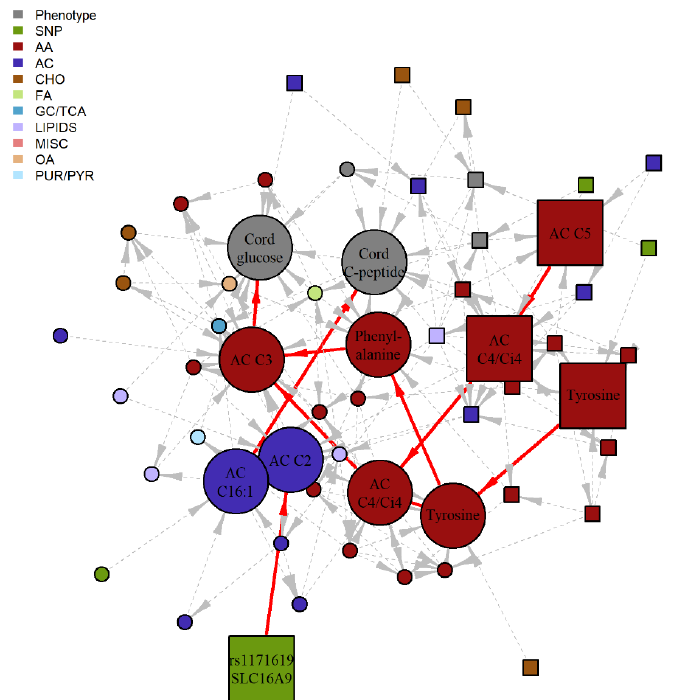
between them. The maternal features are represented by square nodes and the offspring features are represented by circle nodes. Newborn outcome variables are grey, genotypes are green, and the remaining colors correspond to different metabolite classes. The solid, red edges correspond to the purported SMM pathway with statistically significant IDE after FDR correction and positive proportion mediated in the training data set, with nominal significance and positive PM confirmed in the validation data set. Dashed, grey edges correspond to nodes adjacent to the SMM pathway. AA, amino acid; AC, acylcarnitine; CHO, carbohydrate; FA, fatty acid; GC/TCA, glycolysis/tricarboxylic acid cycle; OA, organic acid; PUR/PYR, purine or pyrimidine.